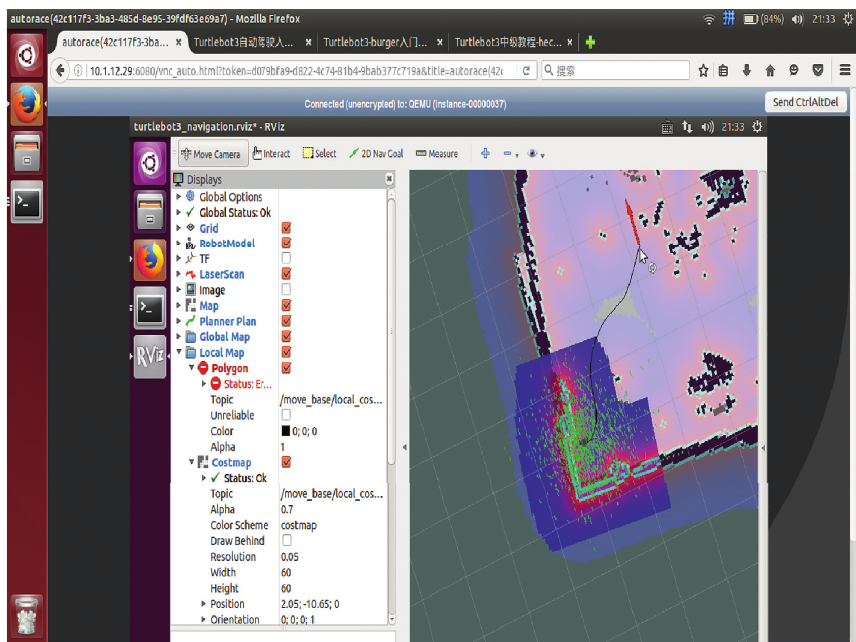
Figure 6: Maps are stored in the